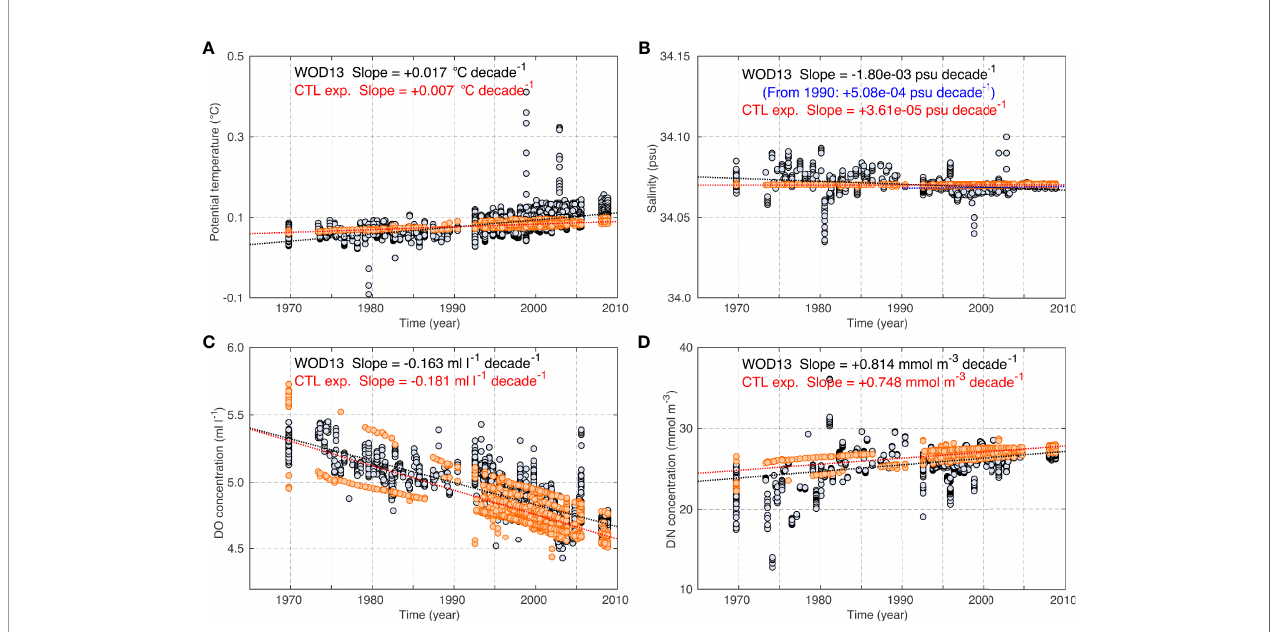
FIGURE 3 | Long-term variation in (A) temperature, (B) salinity, (C) dissolved oxygen (DO) concentration, and (D) dissolved inorganic nitrogen (DIN) concentration at depths from 1500 m to the bottom. The gray and orange circles indicate the observation data and results of the control (CTL) experiment, respectively. The dotted lines denote the linear regression lines of each dataset. All linear trends were statistically signi fi cant at a con fi dence level of 95% ( p <